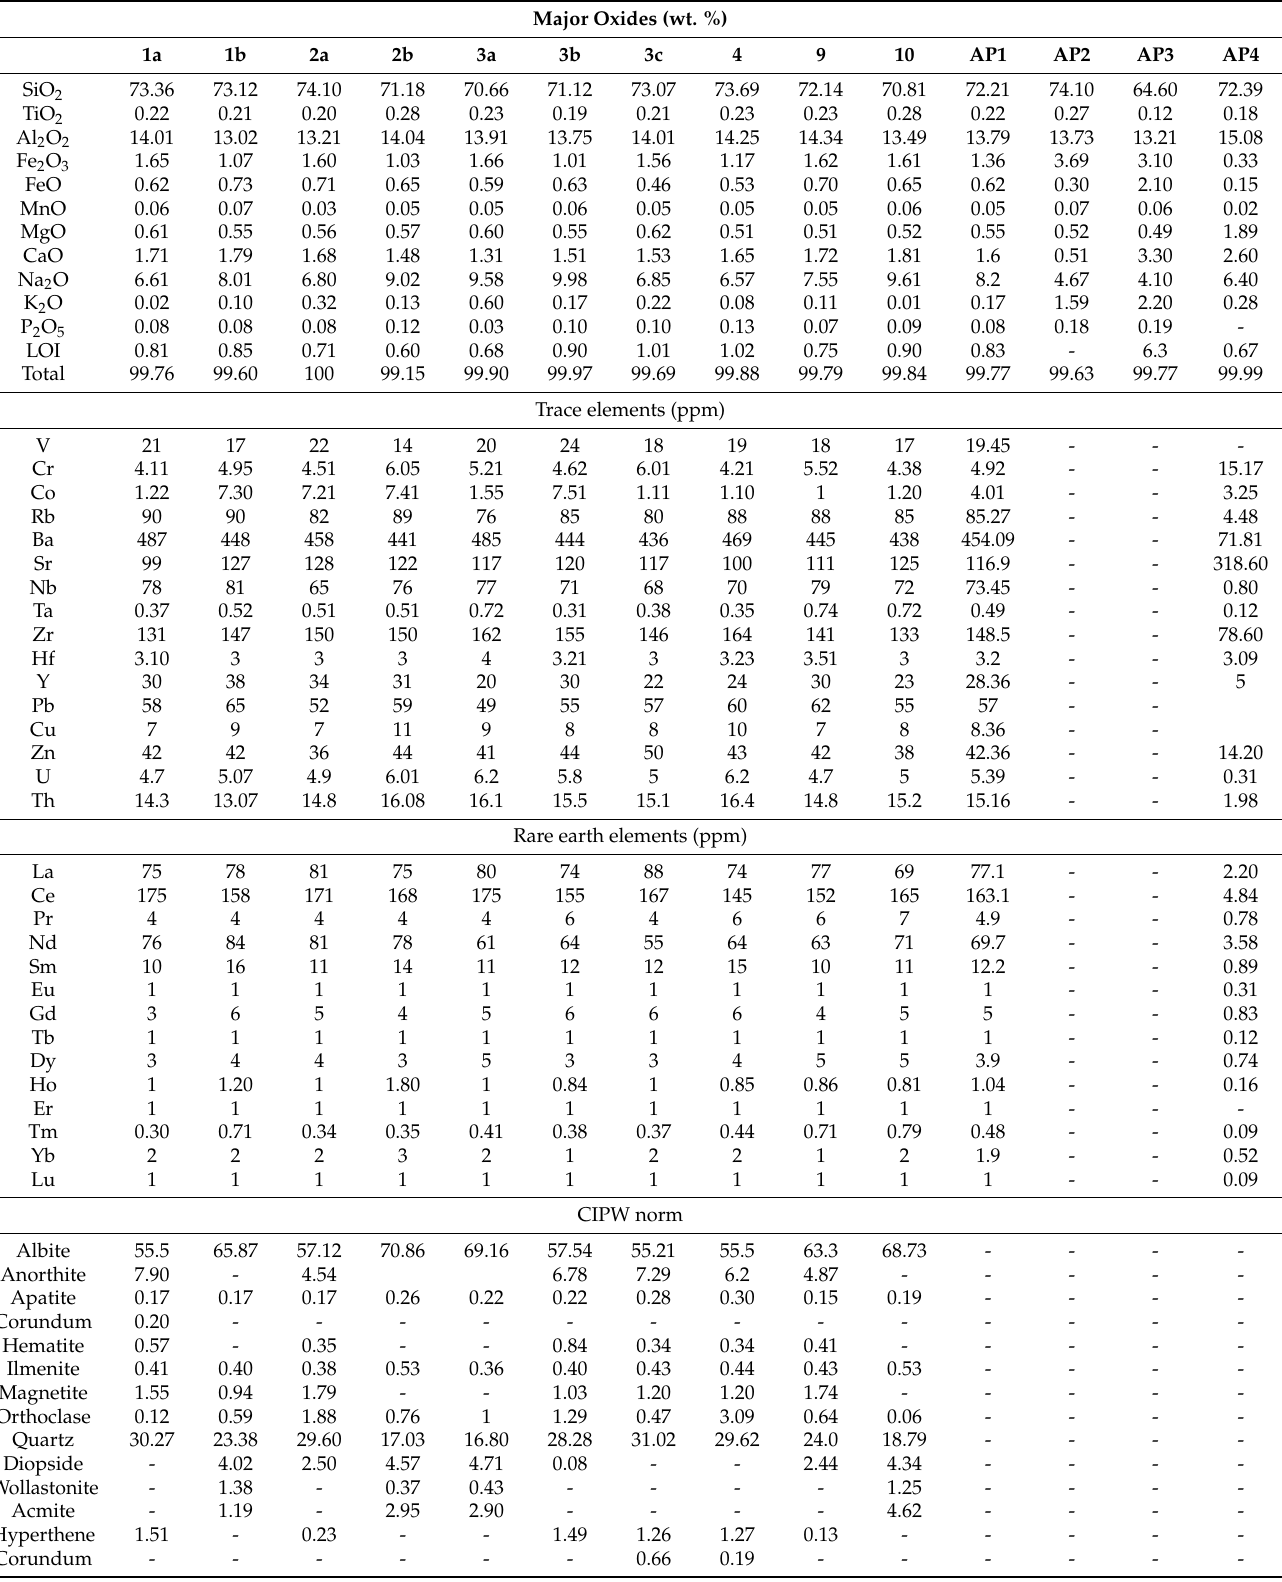
Table 1. Chemical analyses of Abu Dabbab